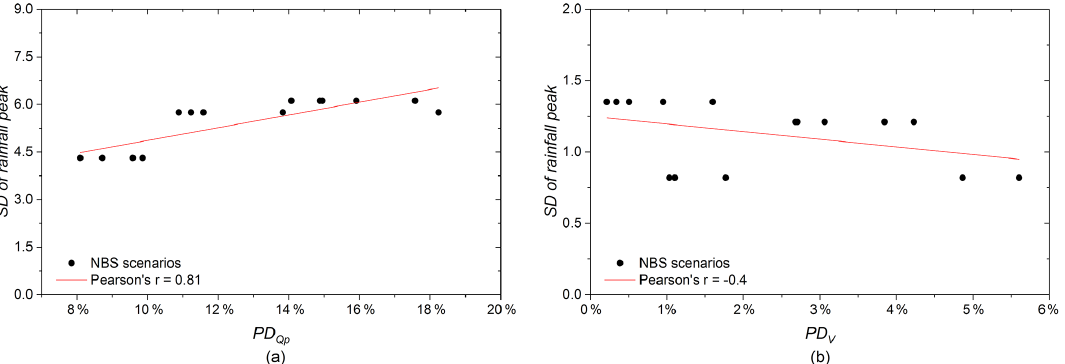
Figure 14. (a) Relationship between the SD of rainfall intensity at the largest rainfall peak and PD Qp of NBS scenarios. (b) Relationship between the SD of total rainfall depth and PD V of NBS